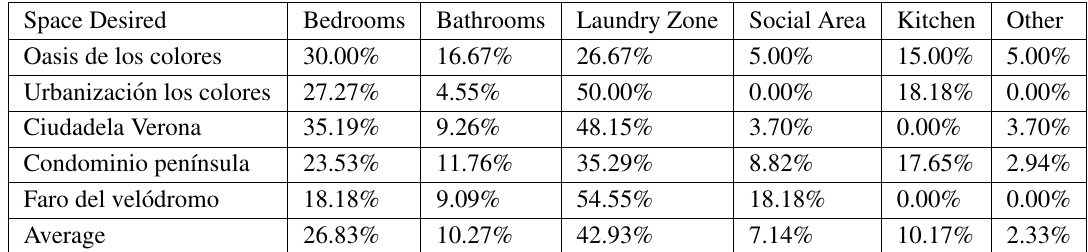
Table 6. Related enclosures with